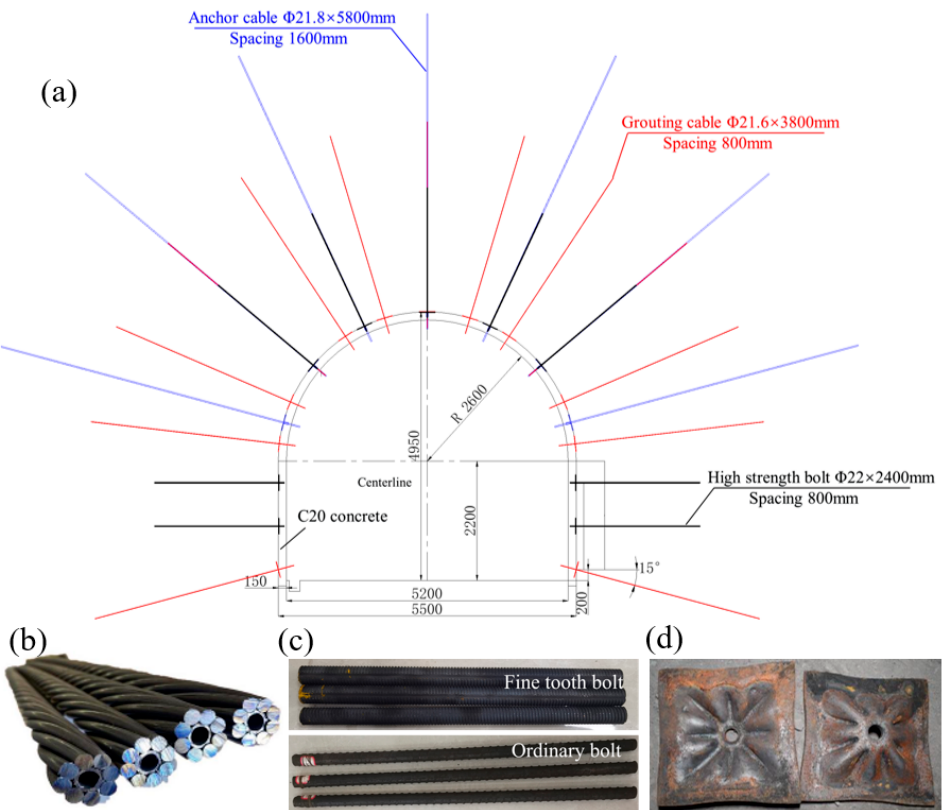
Figure 12. Support scheme and supporting components. ( a ) New support scheme; ( b ) The high- strength grouting cables; ( c ) B olt ; ( d ) Anchor